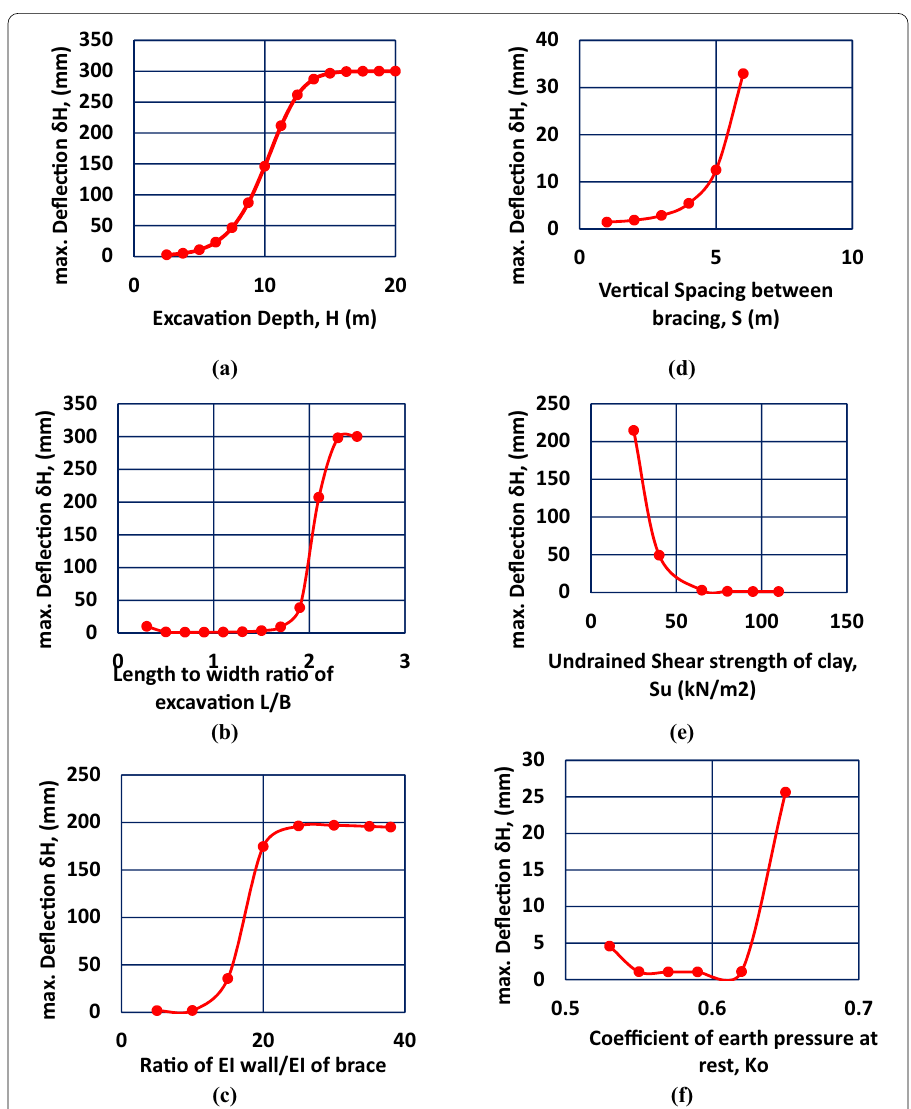
Fig. 9 Result of a parametric study of (ANN) model for the max. excavation under different, a excavation depth, (H), b length to width ratio, (L/B), c ratio of EI wall/EI of bracing, d vertical distance of bracing between spacing, e undrained shear strength, Su, f coefficient of lateral earth pressure at rest